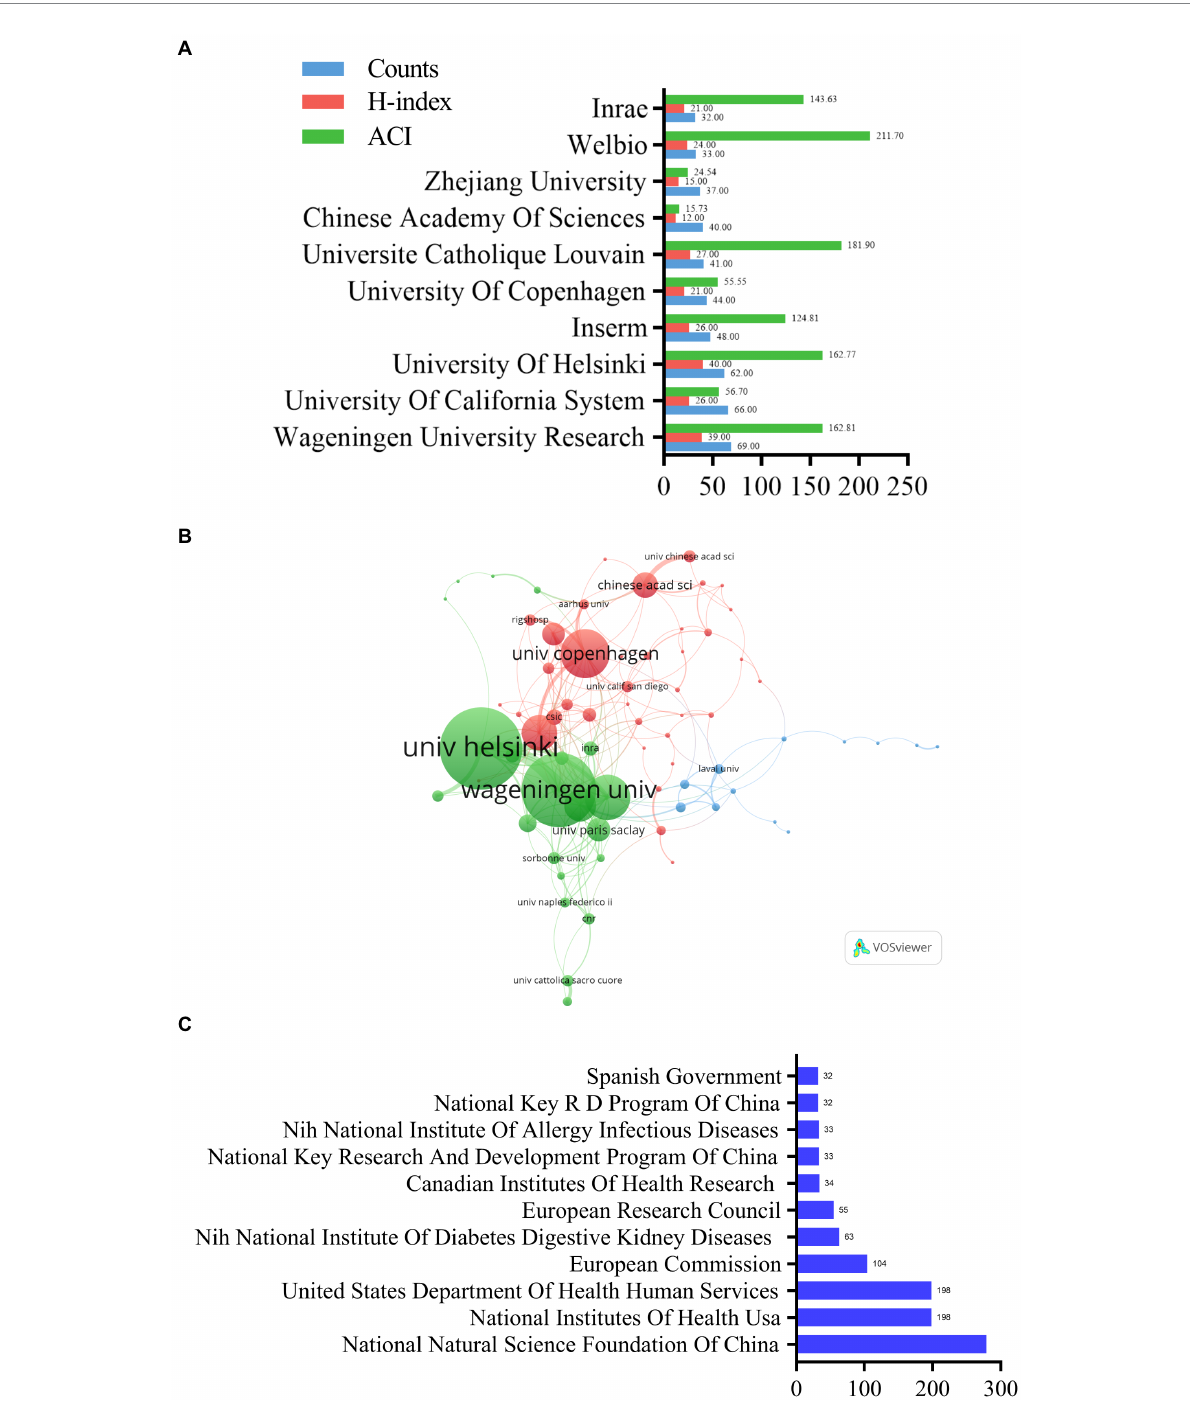
FIGURE 5 Analysis of the contribution of different institutions and funding agencies to A. muciniphila research. (A) The publication counts, H-index, and ACI of the top 10 most productive institutions. (B) Co-authorship analysis of the institutions. Each node represents a different institution. Node size reflects the strength of cooperation. (C) Top 10 related funding agencies which support A. muciniphila research (Spanish Government and National Key RD Program of China tied for